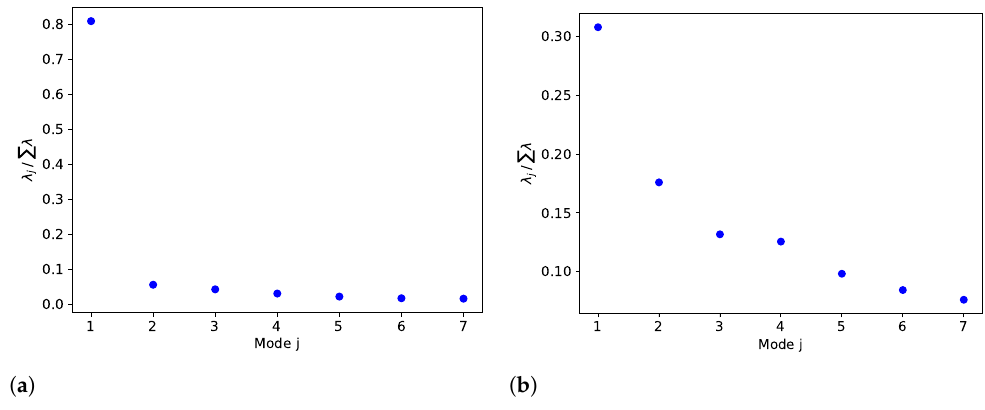
Figure 6. SPOD eigenvalues at two given frequencies. ( a ) 500 Hz. ( b ) 1000